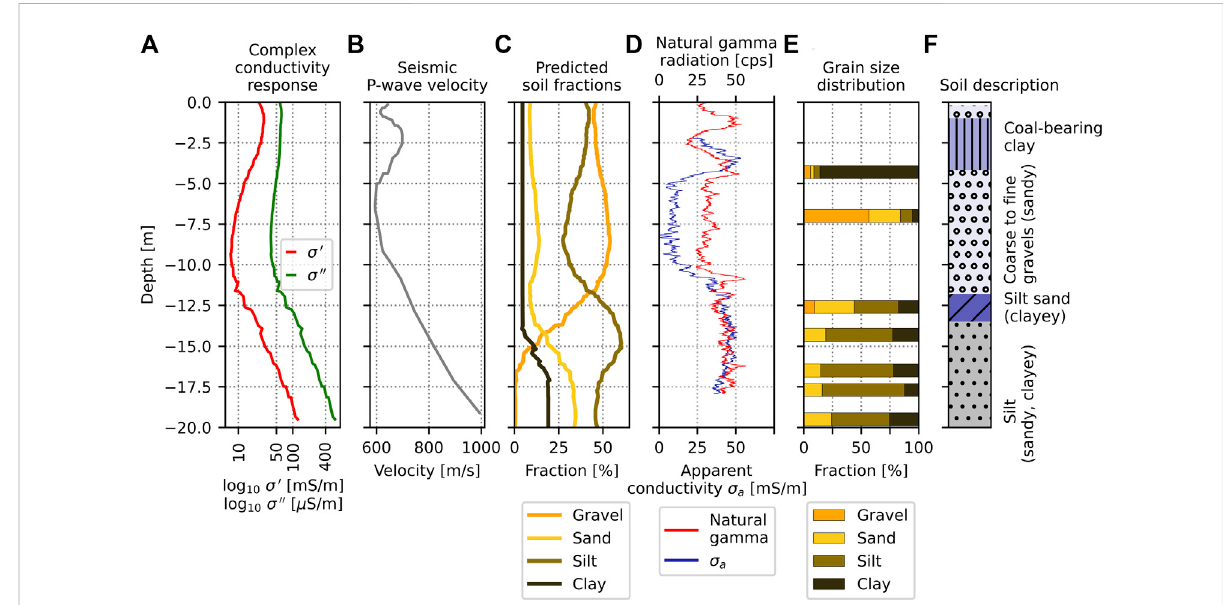
FIGURE 12 Comparison of ground-truth information, complex conductivity response and predicted parameters: (A) complex conductivity response in terms of real σ ′ and imaginary component σ ″ , (B) seismic p-wave velocity and (C) the predicted soil fractions (gravel, sand, silt and clay). (D) presents the natural gamma radiation and apparent conductivity σ a measured with a Dual induction probe inside the borehole WUR04 and (E) grain size distribution, and (F) soil description for samples retrieved from sediments during drilling in